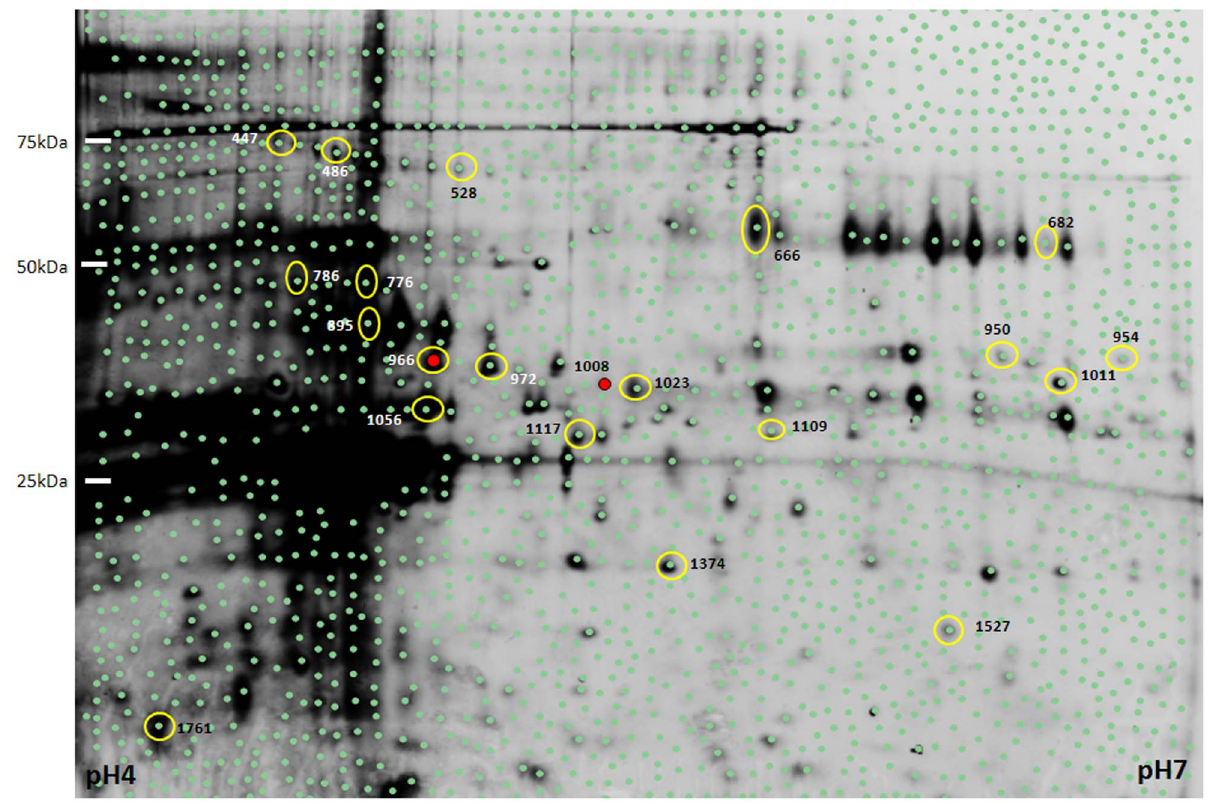
Figure 2. Representative Cy-2 labelled internal standard gel image illustrating the proteins resolved in the pH 4 to pH 7 range. Each green dot represents a feature identified by the DeCyder software. The absence of green dots in the PI 4.5/25 kDa range indicates the location of saturated features that were excluded from the analysis. The Disease Discriminant Classifier was constructed from the 20 features circled in yellow. The positions of the two features utilized to generate the PCA plot in Figure 1 and create a classifier able to discriminate between scrapie infected and age matched control mice with 100% accuracy from 11 weeks post-infection onward are marked with a red dot.